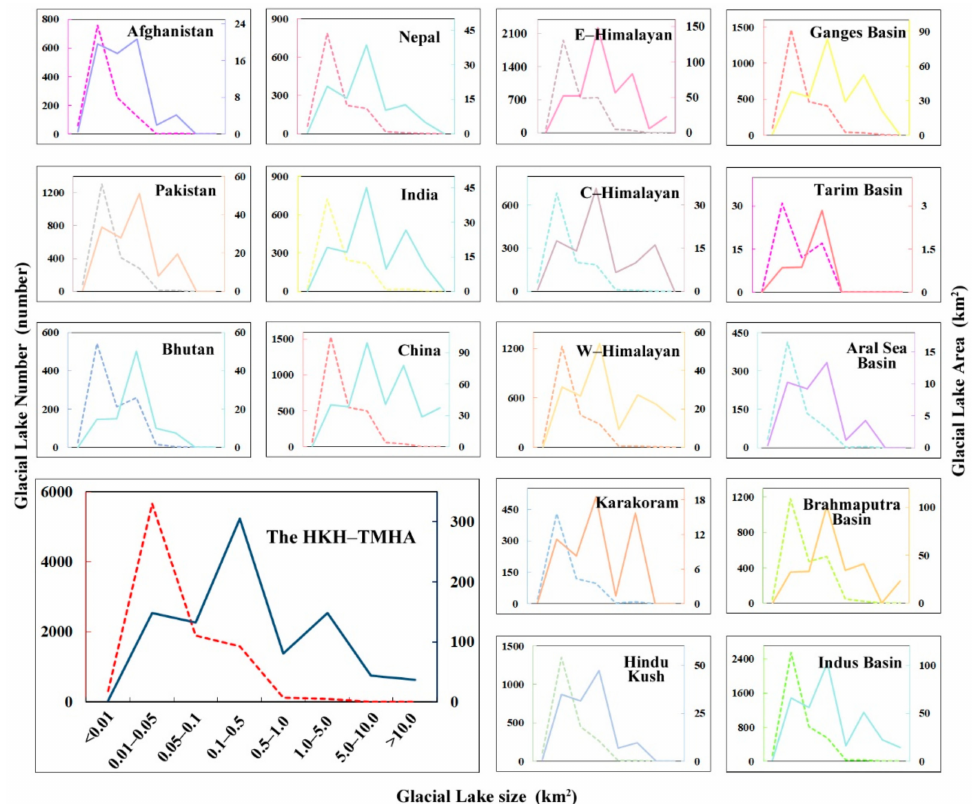
Figure 8. Distribution of glacial lakes of different sizes in the mountains, countries, and basins in the study area in 2020 (here, dotted line charts represent glacial lakes number, and solid line charts represent glacial lakes area; the values of the x axis are <0.01, 0.01–0.05, 0.05–0.1, 0.1–0.5, 0.5–1.0, 1.0–5.0, 5.0–10.0 and >10.0 km 2 from left to right,